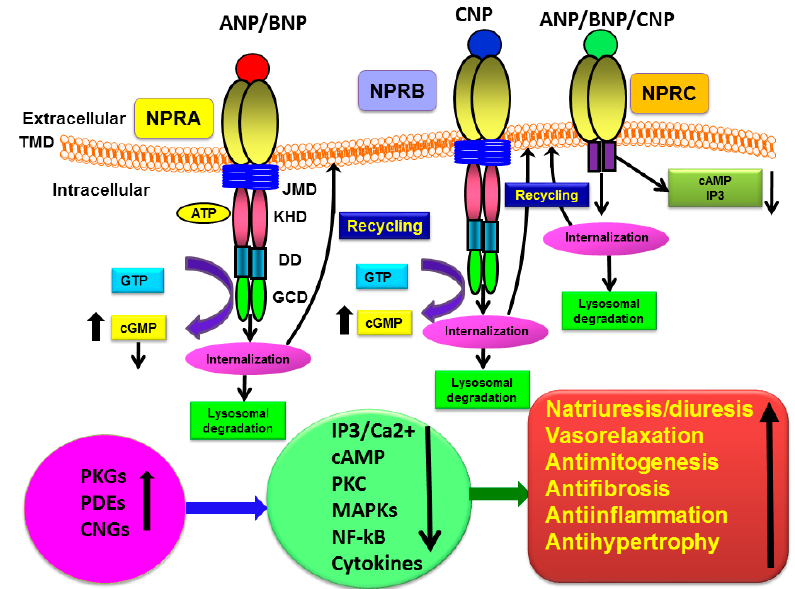
Figure 1. Diagrammatic representation of ligand-stimulation of ligand–receptor complex activation and the physiological functions of natriuretic peptide receptor-A (NPRA), receptor-B (NPRB), and receptor-C (NPRC): Ligand-binding activates NPRA and NPRB, which leads to enhanced production